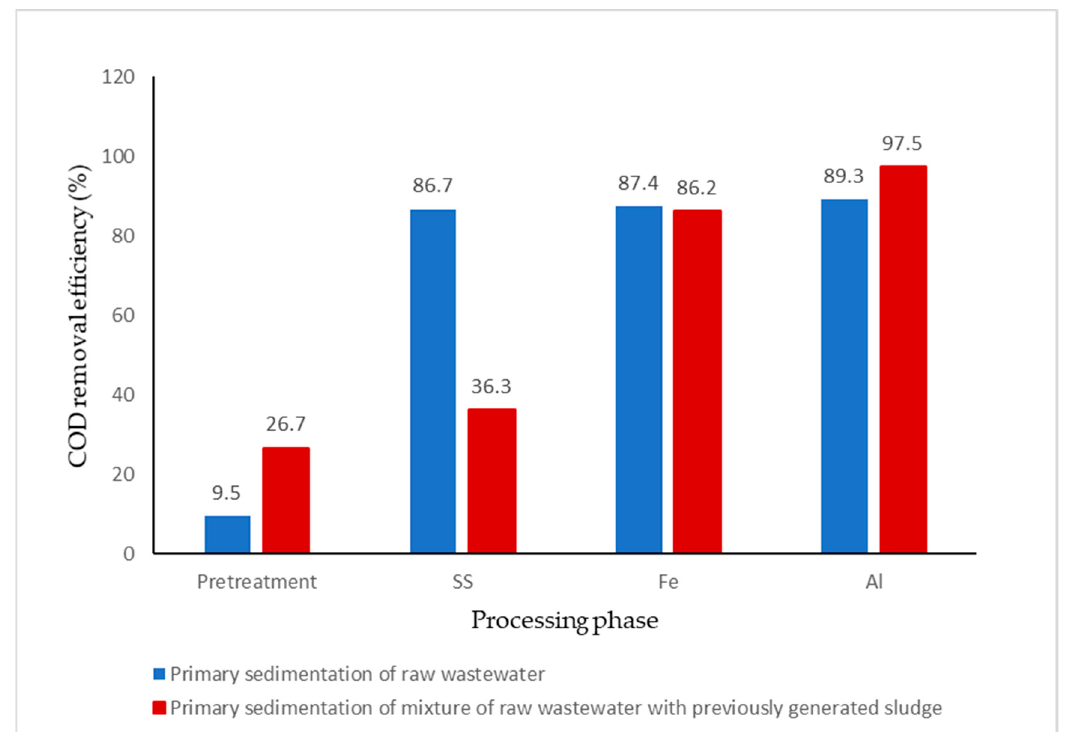
Figure 3. Comparison of removal efficiency of COD by primary sedimentation of raw wastewater followed by EF/EC process, during individual treatment stages using stainless steel (SS), iron (Fe), and aluminum (Al) electrodes, and primary sedimentation of a mixture of raw wastewater with previously generated sludge followed by EF/EC process, during individual treatment stages using stainless steel (SS), iron (Fe), and aluminum (Al) electrodes.